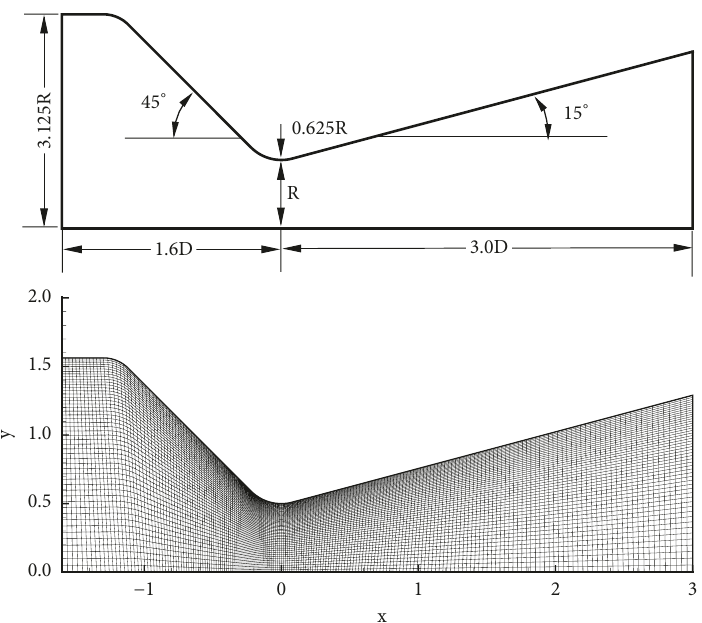
Figure 1: The nozzle configuration and grid system.